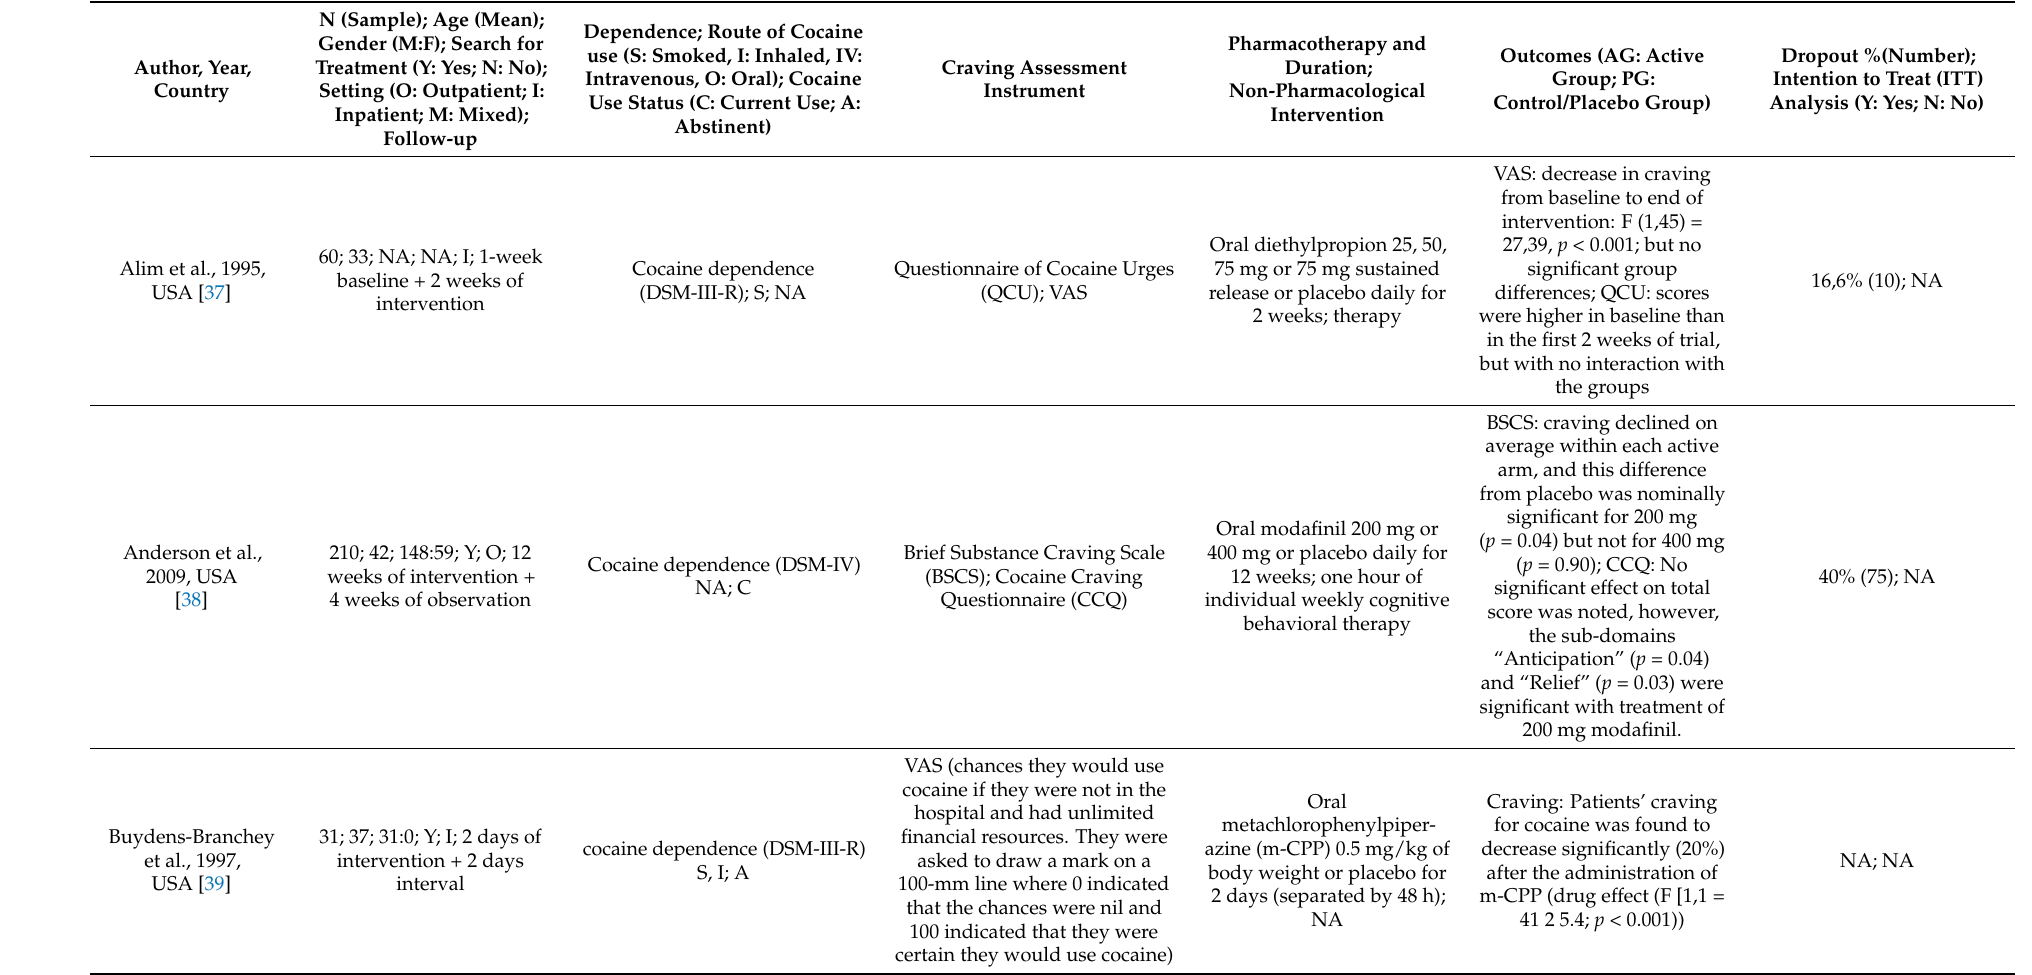
Table 2. Characteristics and main findings of the studies included in the systematic